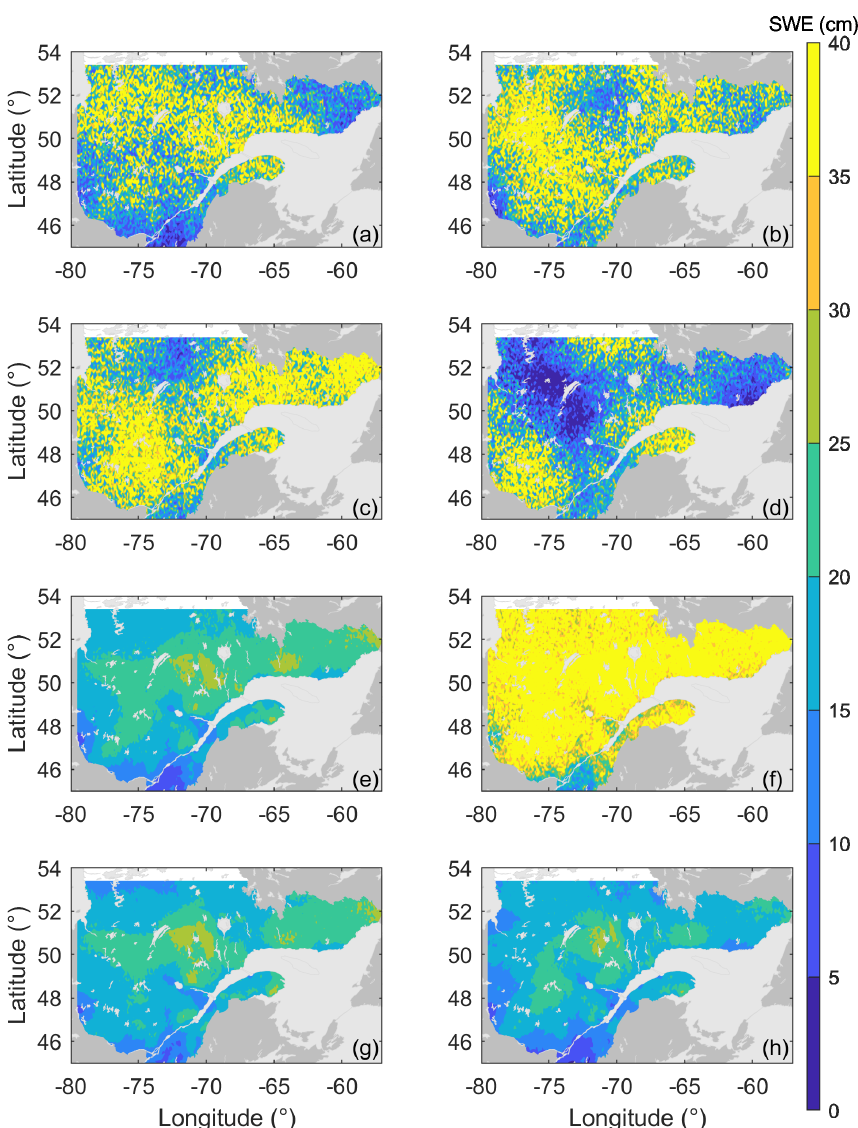
Figure 6. Snow water equivalent (SWE) for two particles on 28 February 2012: particle #250 (a, c, e, g) and particle #500 (b, d, f, h) ; ensemble open loop (a, b) , no reordering (c, d) , sorting (e, f) and Schaake shuffle (g, h) .